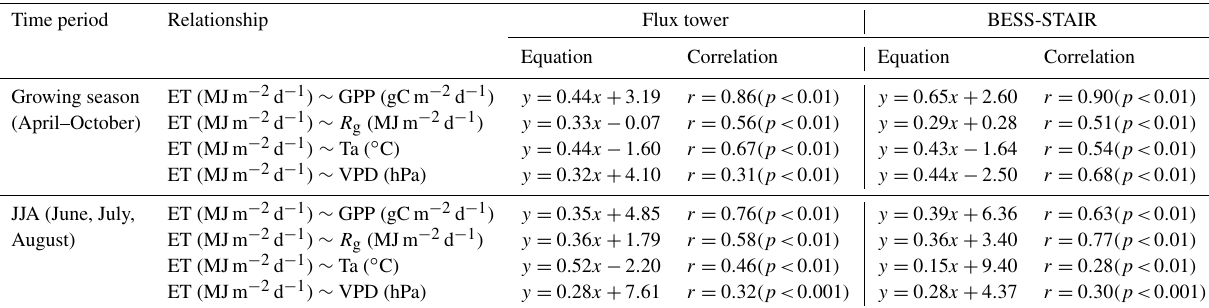
Figure 9. Monthly mean BESS-STAIR ET at Brooks Field (41.9–42.0 ◦ N, 96.65–96.75 ◦ W) during the growing season of 2000, along with a CDL land-cover map. The last subplot shows the average time series of corn, soybean, and grass. Circles indicate flux towers in this region. Table 4. BESS-STAIR captures the correct response of daily ET to GPP, radiation ( R g ), temperature ( T a ), and humidity (VPD) as compared to flux-tower measurements over the three Mead sites from 2001 through 2012. The linear equation slopes and correlation coefficients between ET and other factors are similar in flux-tower measurements and BESS-STAIR estimations, for both the whole growing season (April– October) or only the peak growing season (June, July, and August). For “flux-tower” columns, R g , Ta, and VPD are from site measurements, while for “BESS-STAIR” columns, they are from satellite-derived coarse-resolution